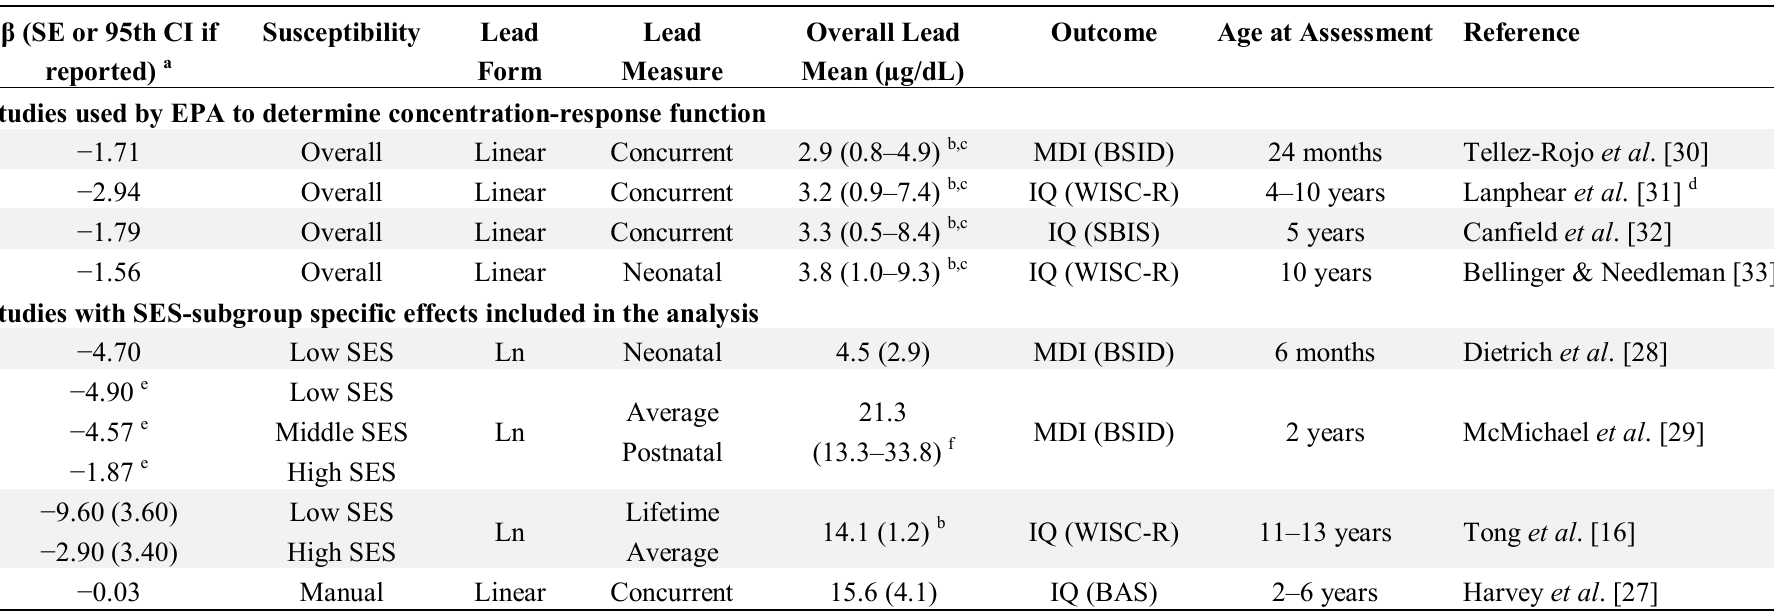
Table 2. Concentration-response functions considered in the